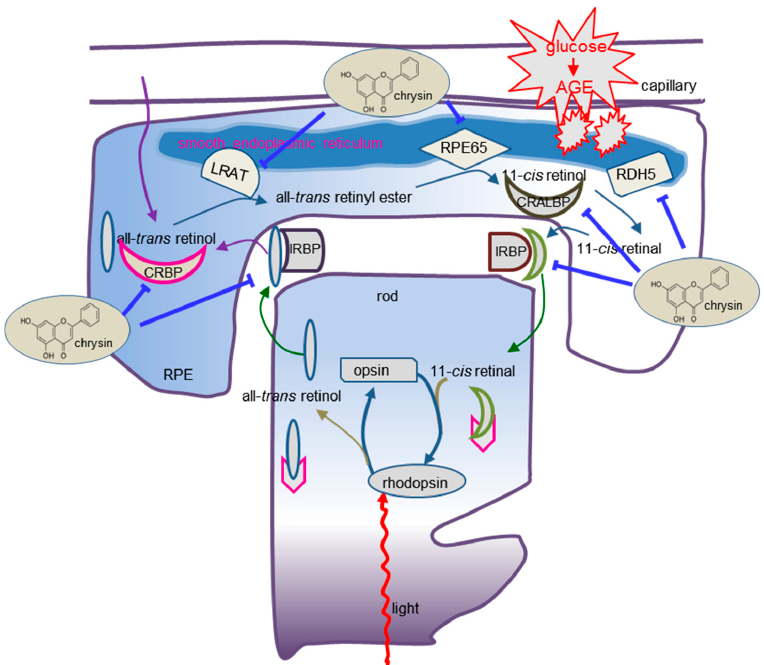
Figure 8. Schematic diagram showing the inhibitory effects of chrysin on the malfunction of retinoid visual cycle and its mechanistic actions in glucose/AGE-exposed human retinal pigment epithelial (RPE) cells. Chrysin inhibited the ER stress activated by glucose/AGEs. All of the arrows indicate increase, activation or induction; ⊥ indicates inhibition or blockade.